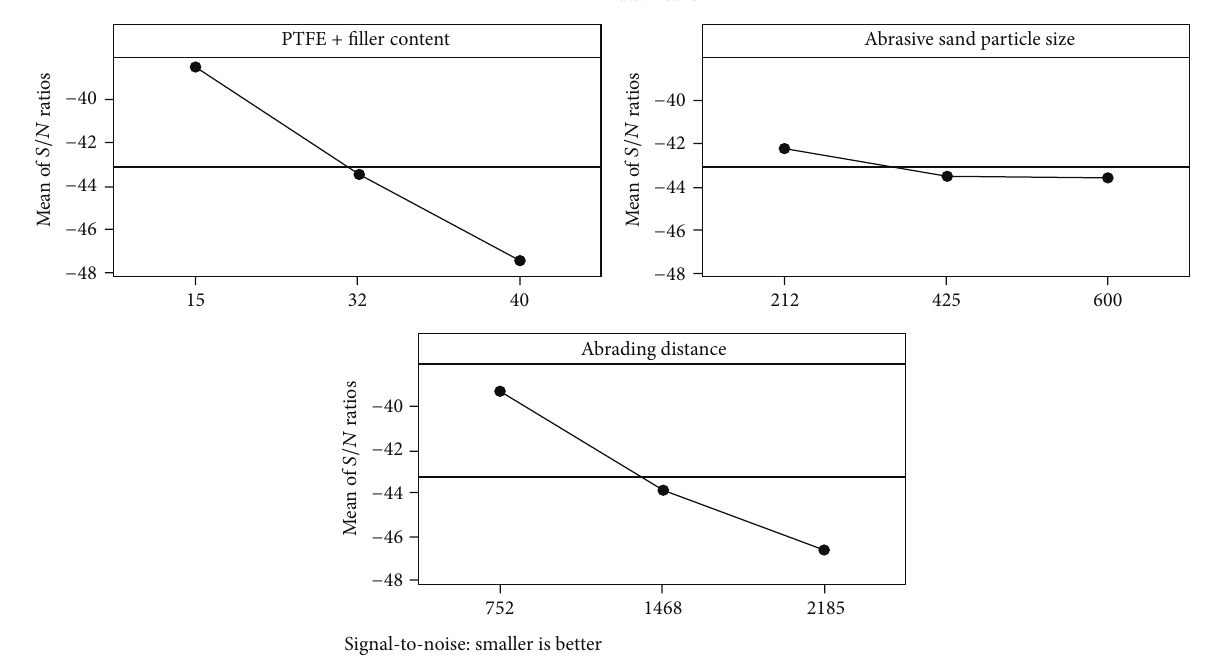
Figure 7: Main effects plot for 𝑆/𝑁 ratio of TCE